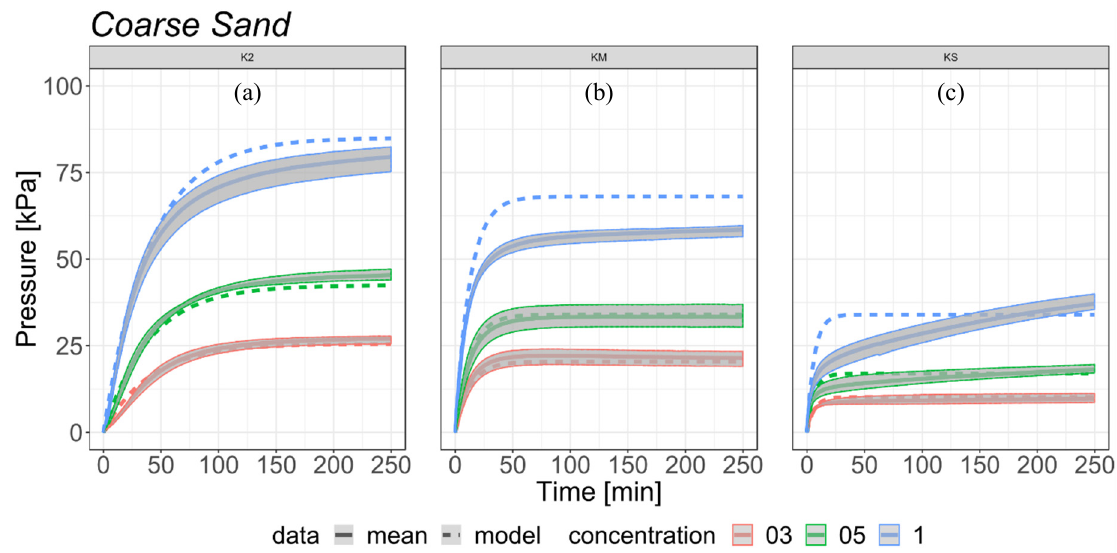
Figure 6. Comparison of the estimated model (dotted line) with measured data (continuous line) of SAP-coarse sand mixtures with range of variability (grey area) based on all experiments in the selected scenario: (a) K2; (b) KM; (c) KS.